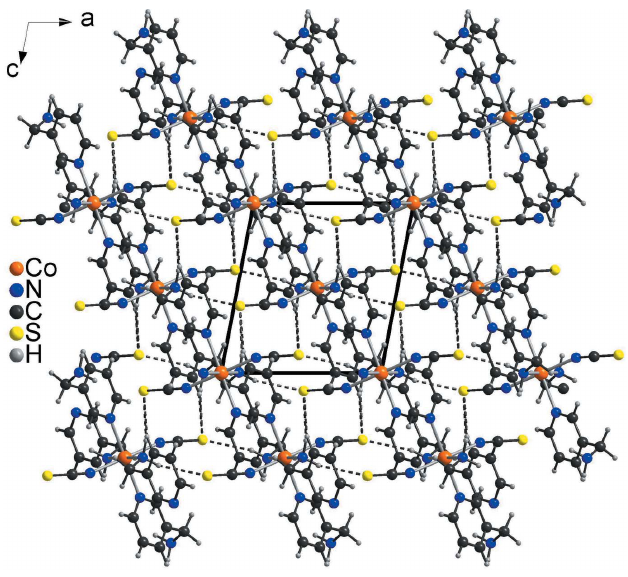
Figure 2 Crystal structure of the title compound viewed along the crystallographic a axis. The H atoms are omitted for clarity.